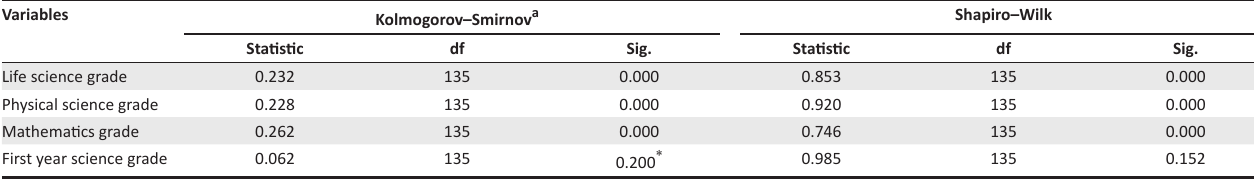
TABLE 1: Tests of normality.